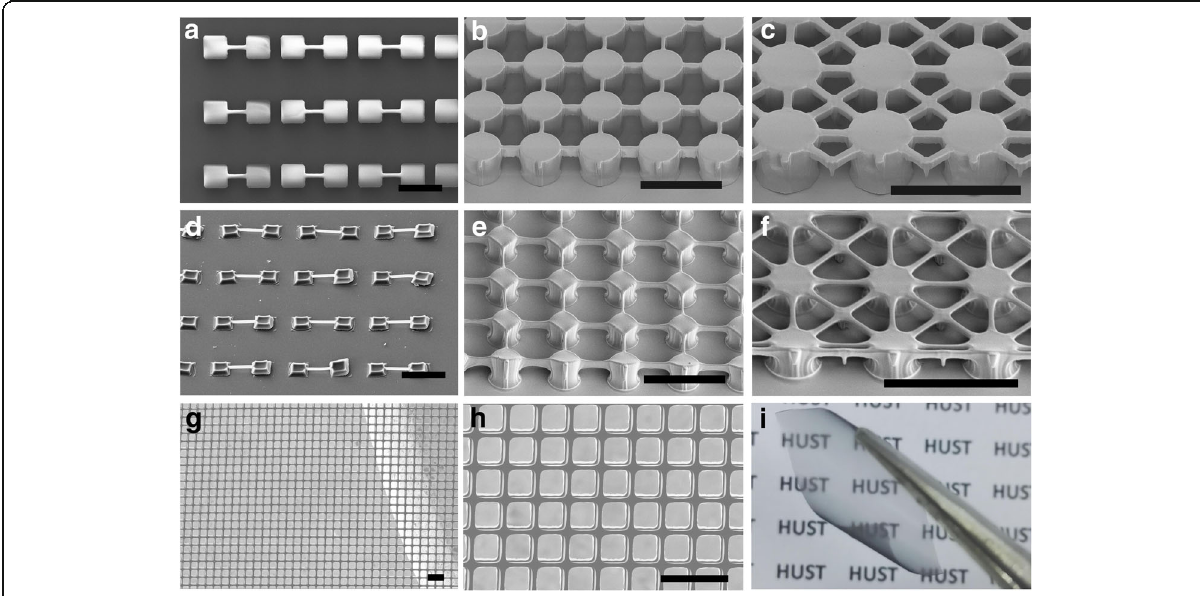
Fig. 7 Suspended SU-8 meshes and pyrolytic carbon meshes. a Suspended SU-8 beams. b , c Suspended SU-8 meshes with supporting pillars. d Suspended carbon beams, where great strains remained in the carbon structures and cracks occurred at the bottom of the pillar. e , f Suspended carbon meshes. g Free-standing carbon mesh after pyrolysis. h Magnification of the free-standing carbon mesh. i A 12 mm × 20 mm free-standing carbon mesh, which presents well flexibility and transparency. The scale bars are 100 μ